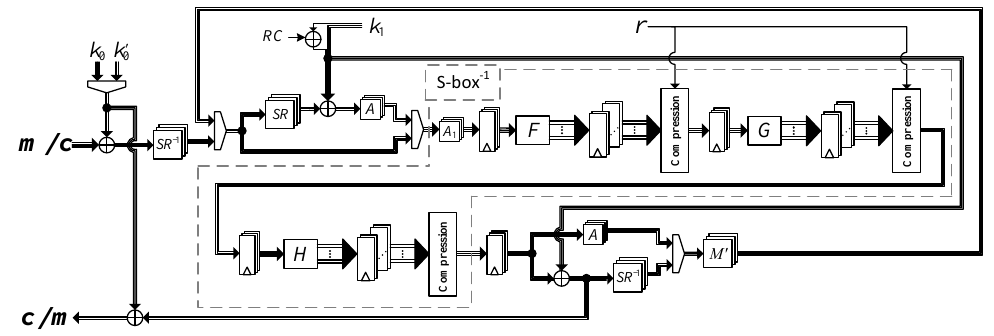
Figure 5: Design architecture of our round-based second-order PRINCE encryp- tion/decryption